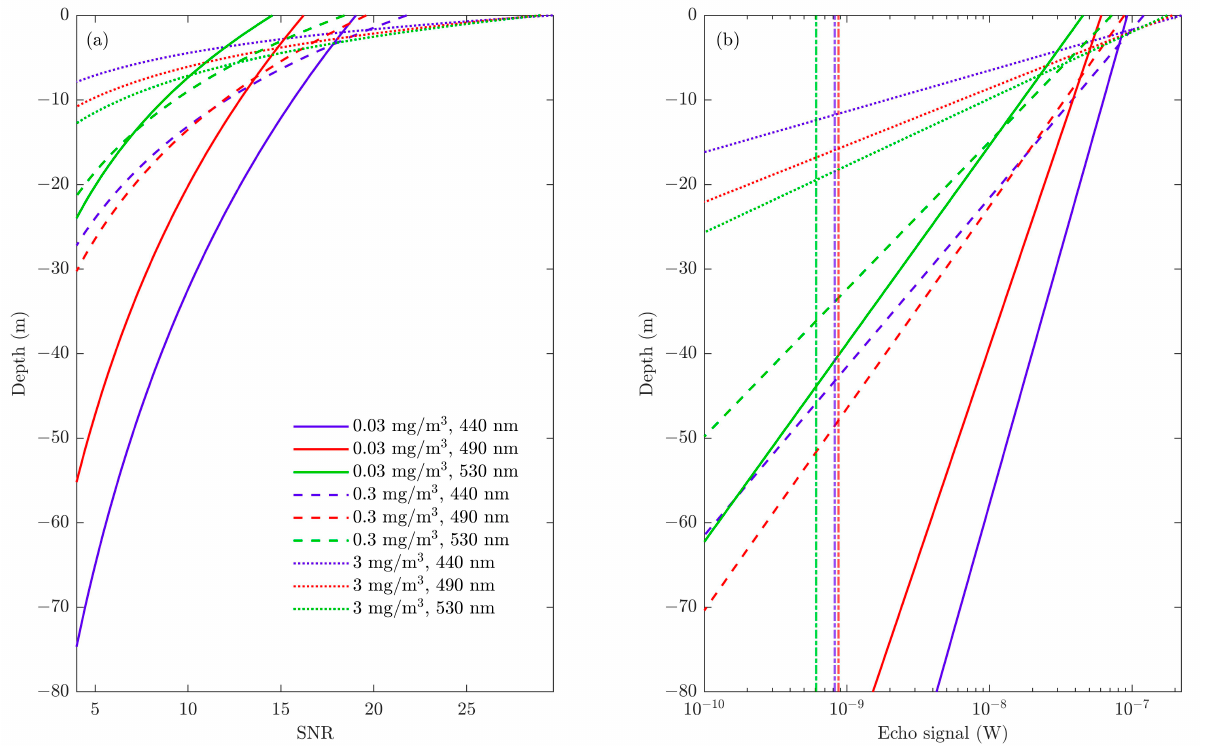
Figure 5. Simulated SNR ( a ) and echo signal ( b ) in the case of water condition with chlorophyll concentration of 0.03 mg/m 3 , 0.3 mg/m 3 , and 3 mg/m 3 . The vertical lines represent the corresponding solar background.